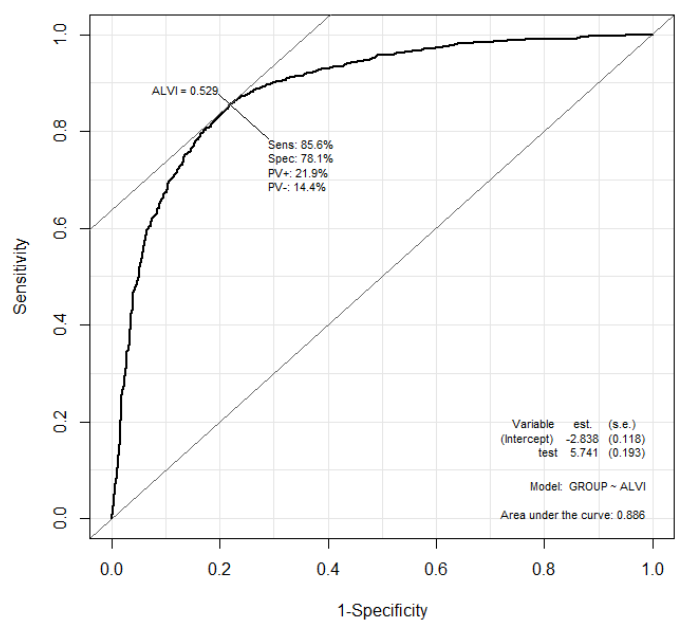
Figure 2. Receiver operating characteristic curve when arousal level voice index identifies utterance data of low arousal level and high arousal level in the Interactive Emotional Dyadic Motion Capture database. The horizontal and vertical axes represent 1-specificity (false positive rate) and sensitivity (positive rate), respectively. (Note. ALVI: arousal level voice index).